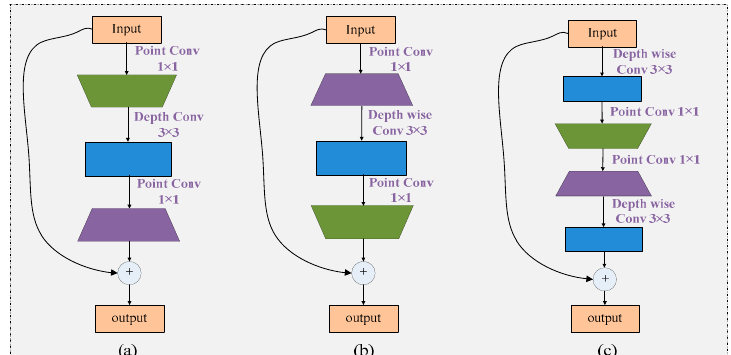
Figure 2. Different structural block designs. ( a ) Residual bottleneck design; ( b ) Reverse residual bottleneck design; ( c ) Residual sandglass design.